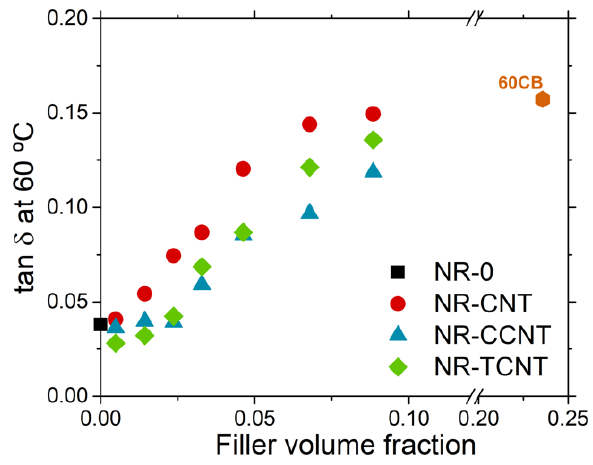
Figure 17. Value of tan δ at 60 °C for NR/CNT, NR/CCNT, and NR/TCNT composites.